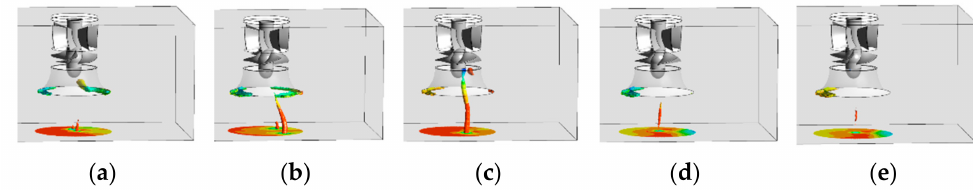
Figure 7. Vortex shape at different stages. ( a ) inception stage, ( b ) development stage, ( c ) continuance stage, ( d ) collapse stage, and ( e )disappearance stage.